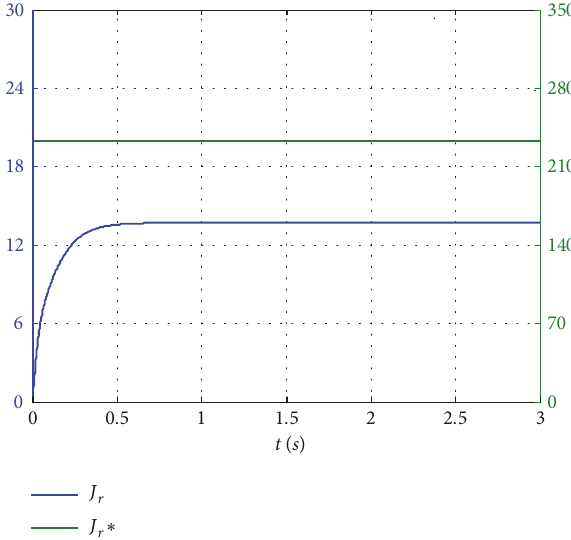
Figure 4: Guaranteed-performance function of multiagent system